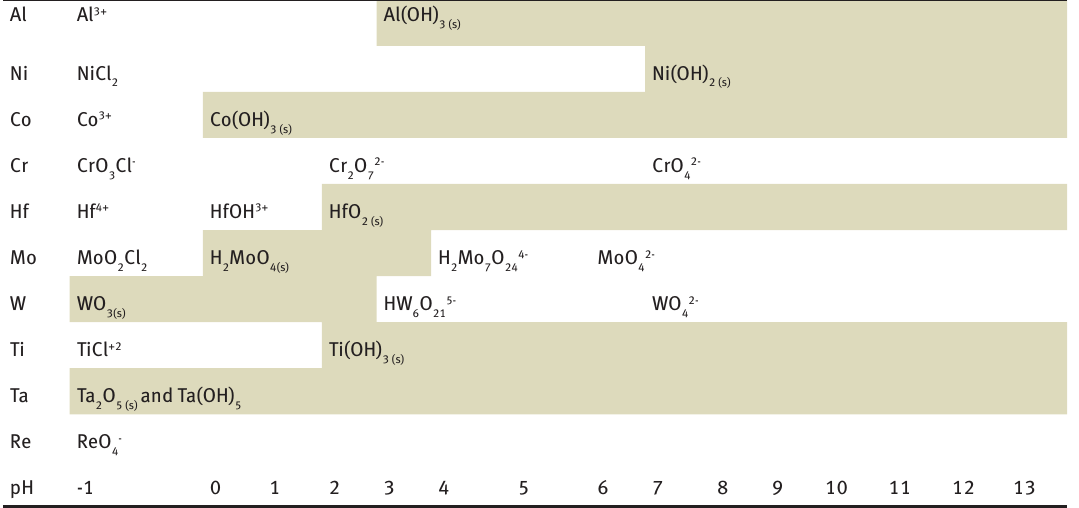
Table 1: Different speciation for the different metals depending on pH, where the shading indicates the presence of a precipitate.